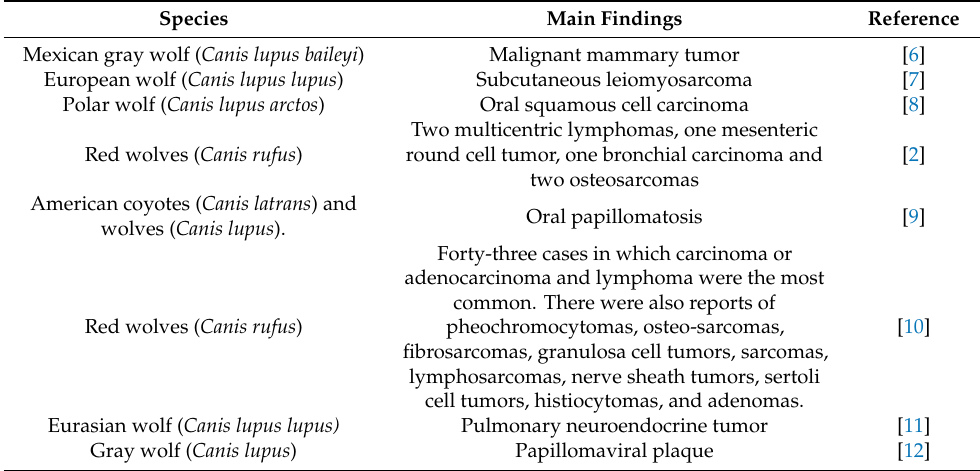
Table 1. List of current publications describing neoplasm in wolves including species and main pathological